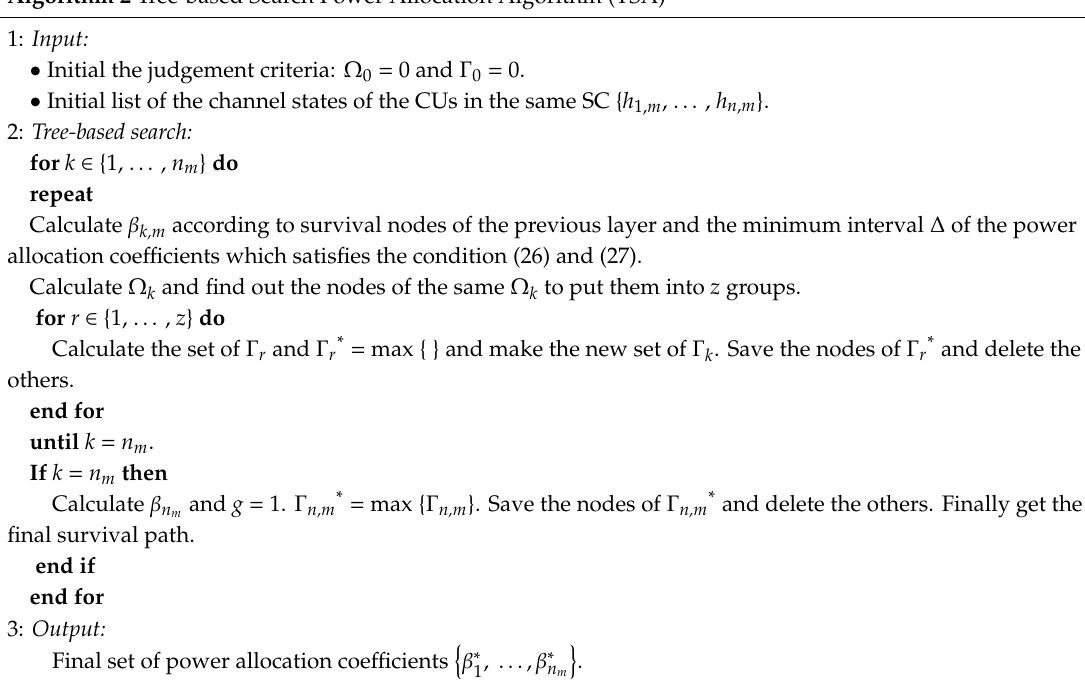
Algorithm 2 Tree-based Search Power Allocation Algorithm (TSA)